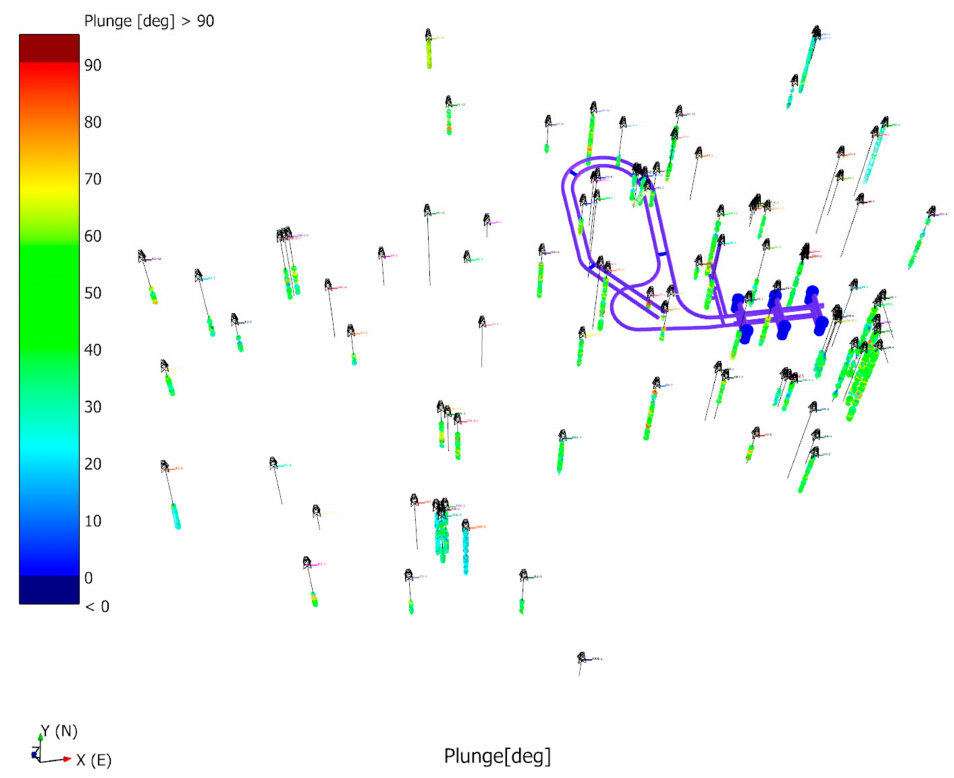
Figure 5. Result of the BHTV logs in the boreholes.